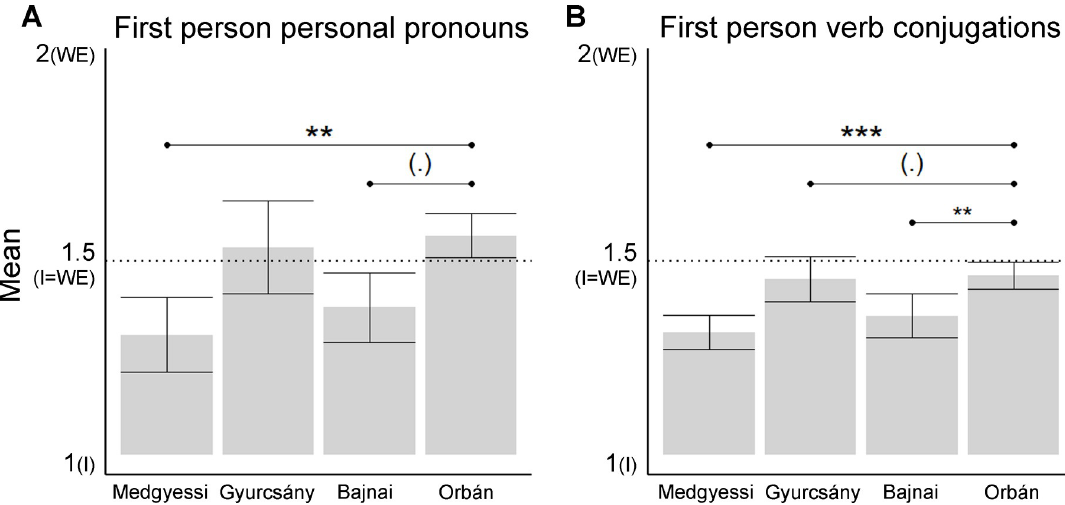
Fig 4. Mean of the categorical variable coding the first-person plurals and singulars. Means are shown A) for personal pronouns and B) for verb conjugations for each Hungarian PMs (x-axis). On the y-axis 1 indicates the exclusive use of singulars (“I”), while 2 indicates the exclusive use of plurals (“we”). For Gyurcsa´ny and Orba´n, the second term of their premiership is plotted. Error bars show confidence intervals, horizontal lines show significant differences and trends between PMs. (.): p < .1. � : p < .05. �� : p < .01. ��� : p <